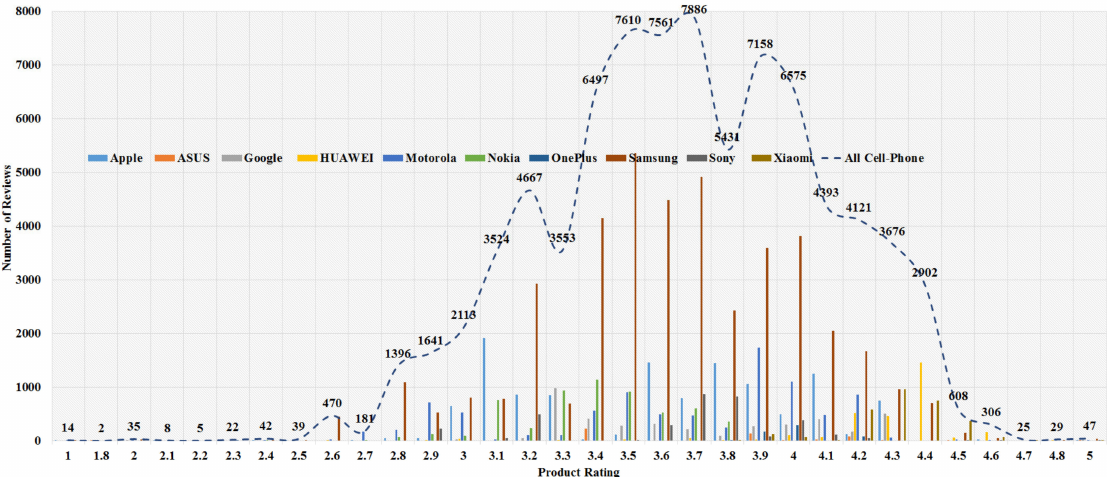
Figure 7. Brand wise and rating wise number of total reviews of products in the